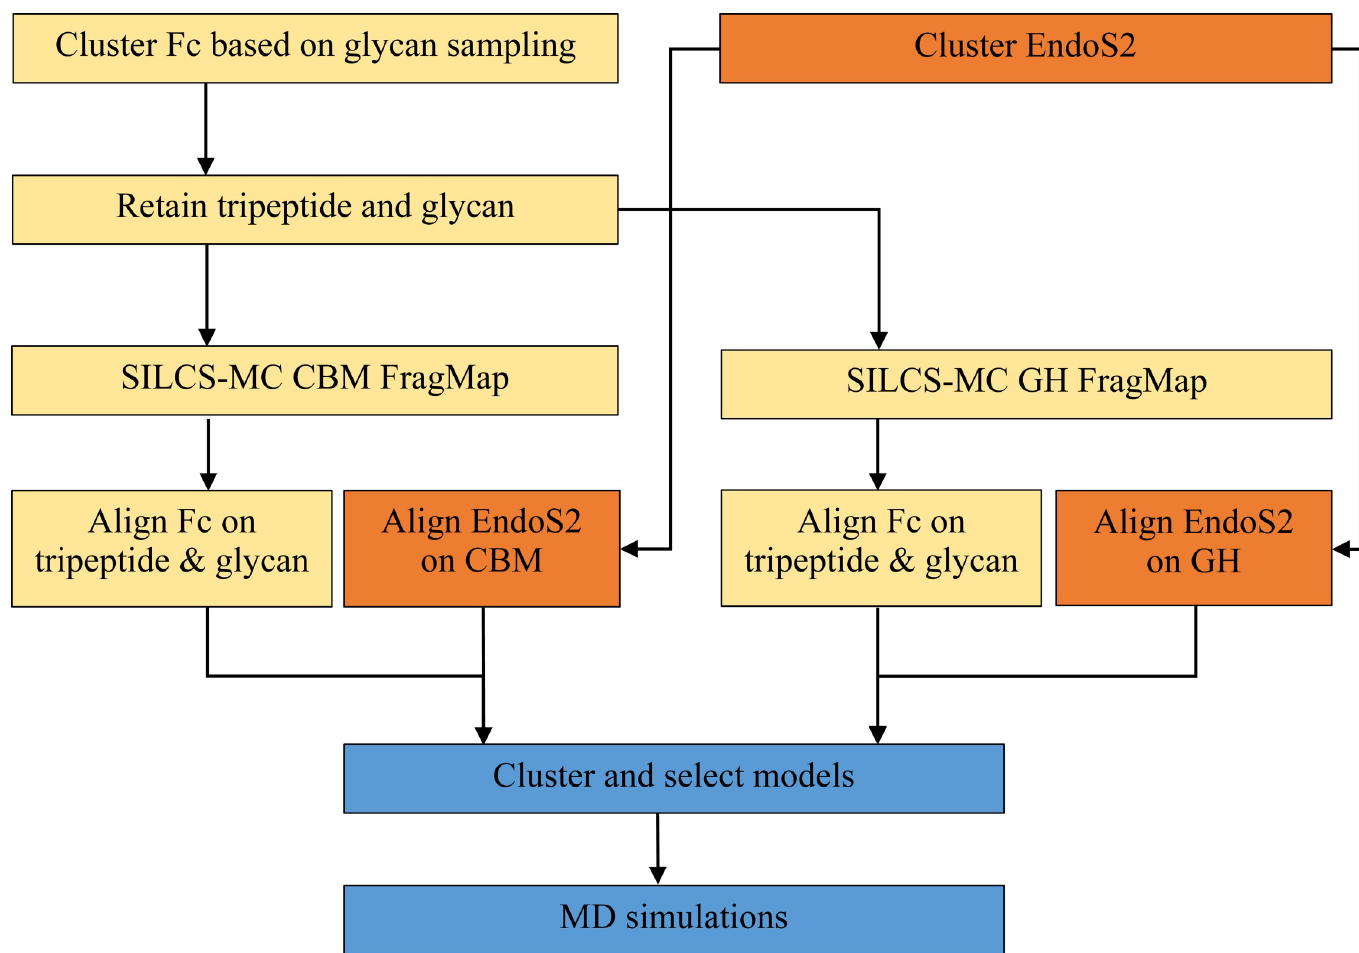
Fig 14. Workflow used for the reconstruction of the EndoS2-Fc-glycan